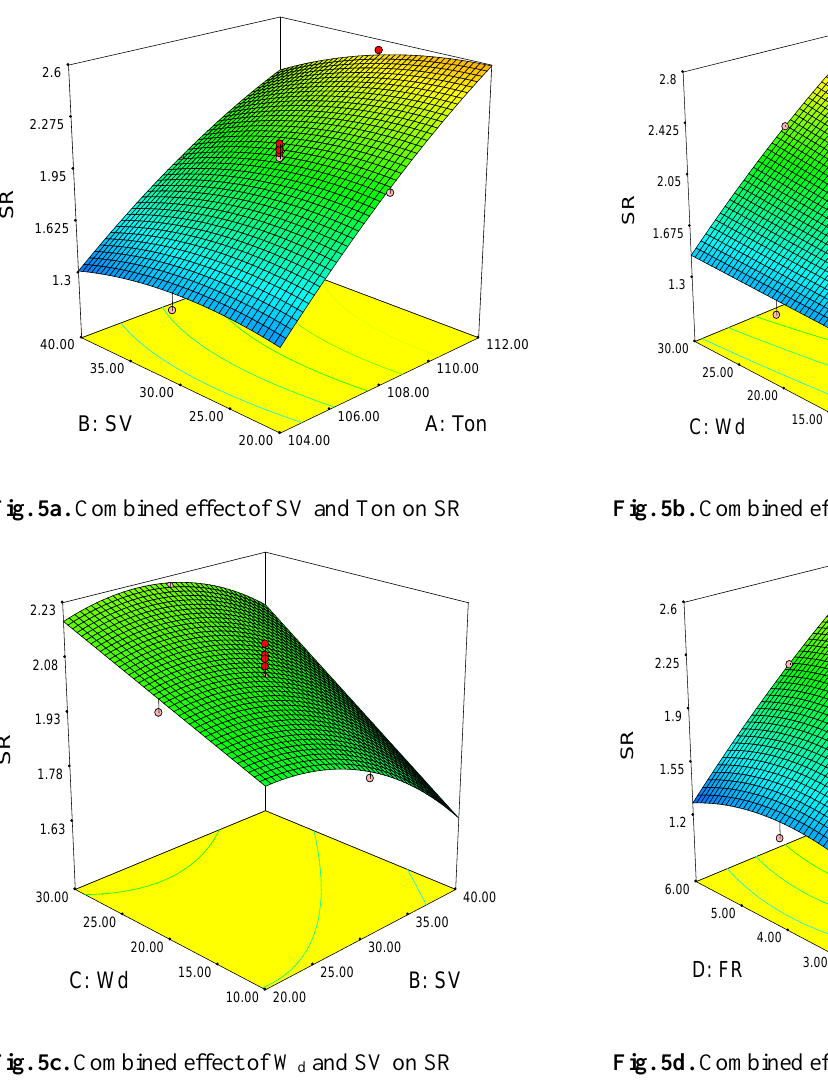
Fig. 5c. Combined effect of W d and SV on SR Fig. 5d. Combined effect of FR and Ton on